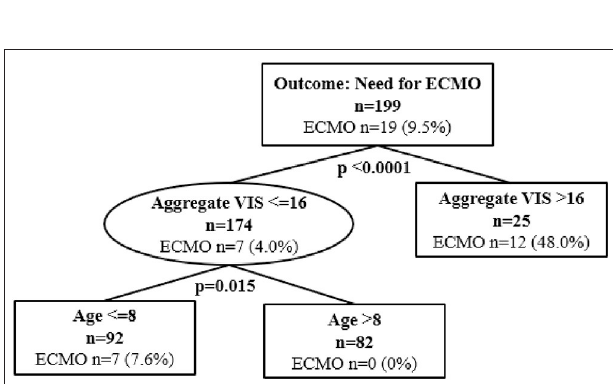
FIGURE 2 | Classification and regression tree (CART) analysis for in-hospital mortality. N = 199. 15 subjects did not have a lactate drawn during the hospitalization. In CART analysis missing values are handled by the software substituting surrogate splitters.